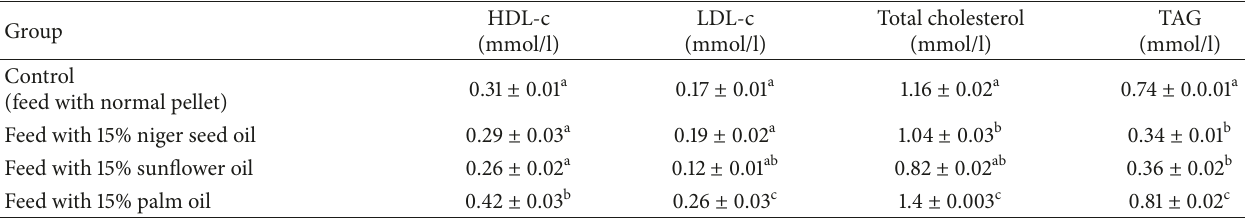
Table 1: The effect of niger seed oil, sunflower oil, and palm oil on blood serum total cholesterol, TAG, HDL-c, and LDL-c at the end of study period.